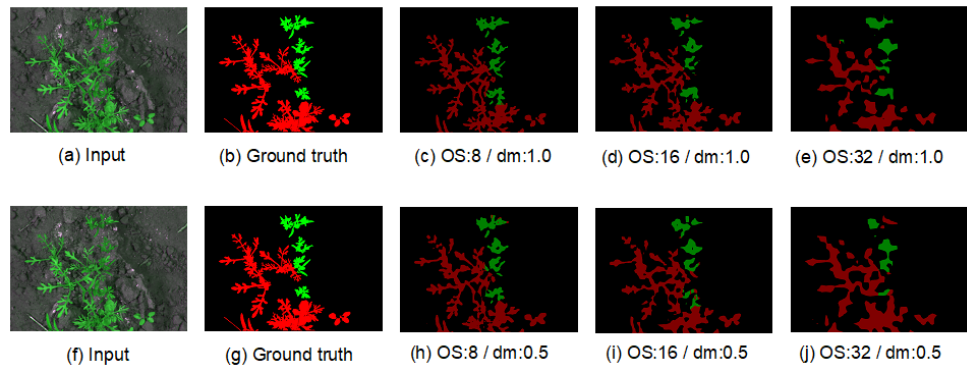
Figure 10. Qualitative segmentation results for the CWFID dataset. The labels of each subimage, except input and ground truth, denote the optimization used in the model to obtain the segmentation results according to Table 8.